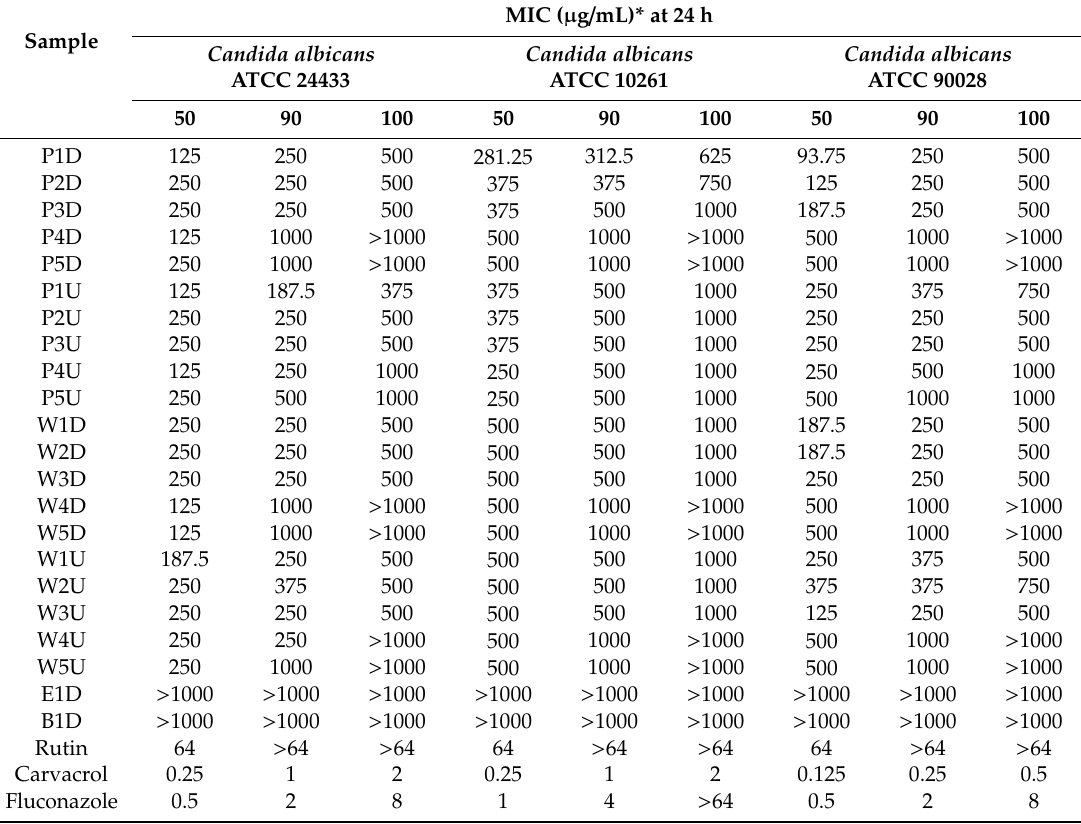
Table 4. Antifungal activity of goji berry extracts and reference compounds expressed as an MIC ( µ g /